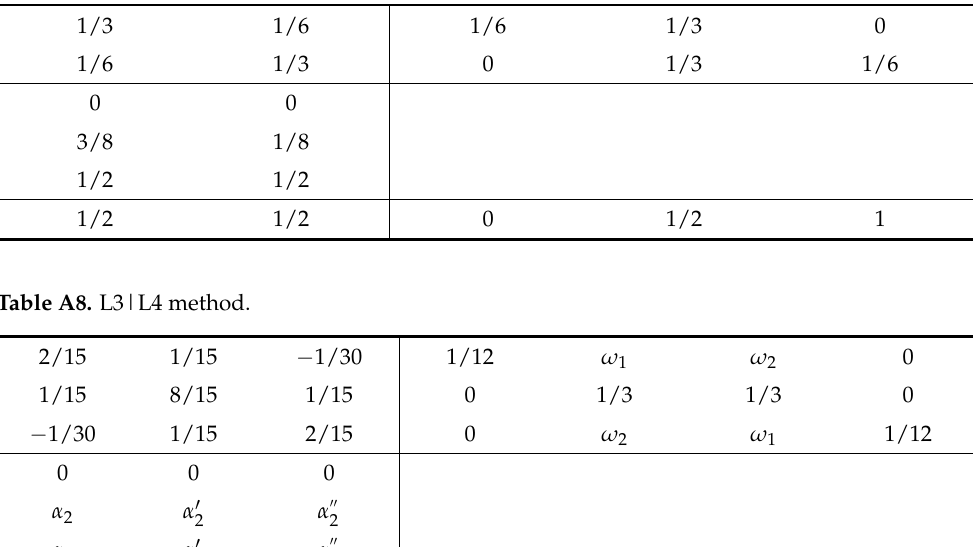
Table A7. L2|L3 method.